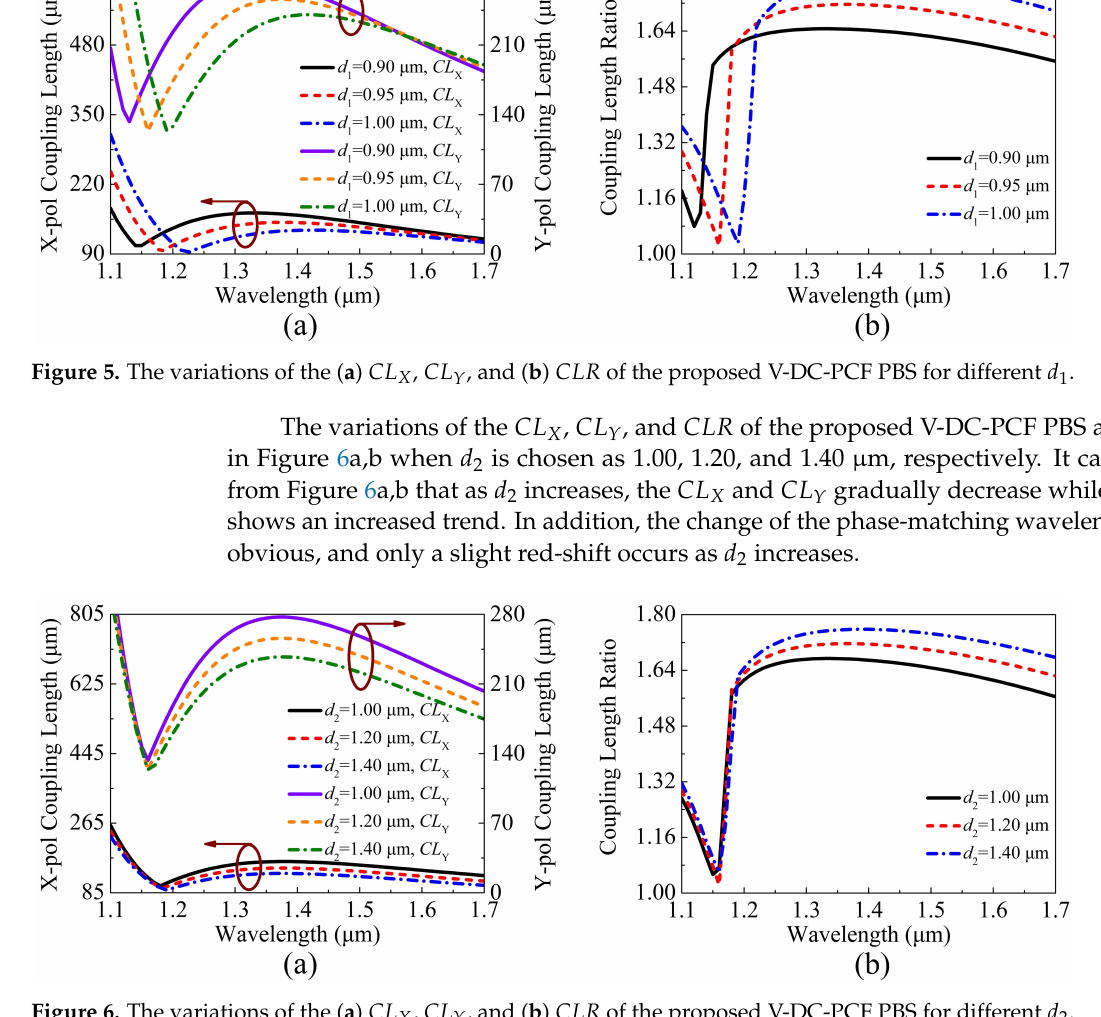
Figure 6. The variations of the ( a ) CL X , CL Y , and ( b ) CLR of the proposed V-DC-PCF PBS for different d 2